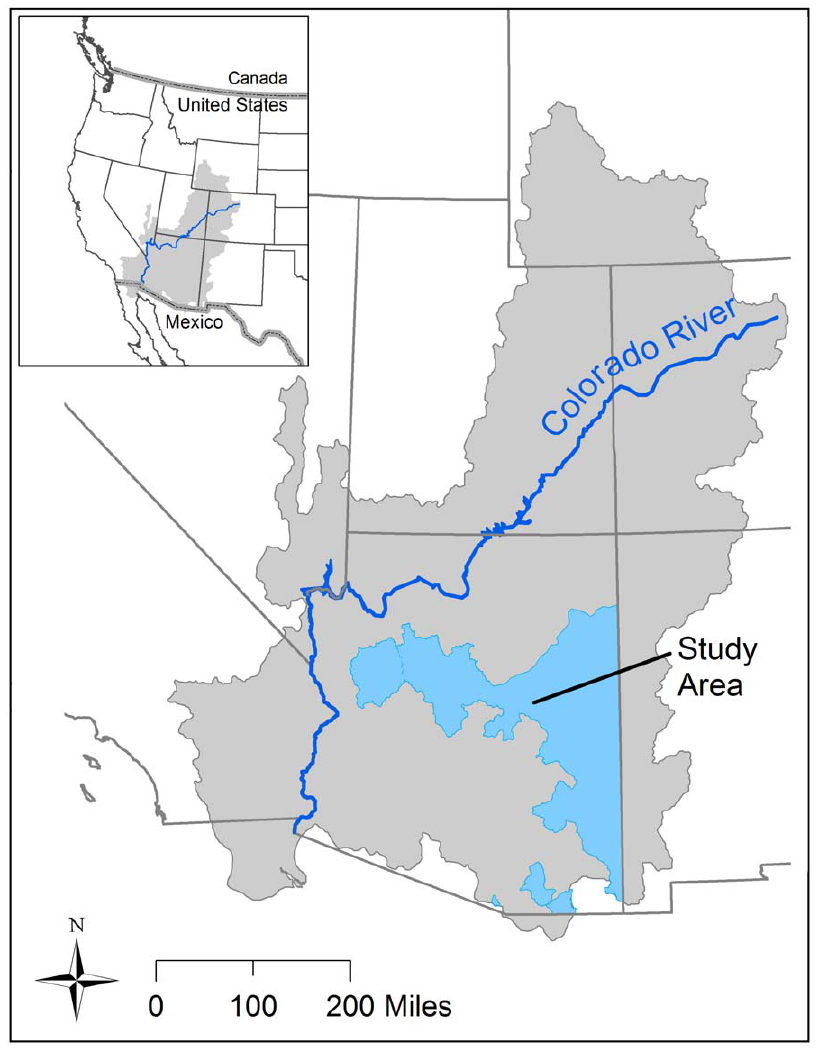
Figure 3. Regional significance of the study watersheds to species. Nearly one-half (45%) of the aquatic, wetland and riparian species that are listed under the U.S. Endangered Species Act in the Colorado River Basin occur in the watershed basins of this study. Inset: Colorado River Basin within North America.